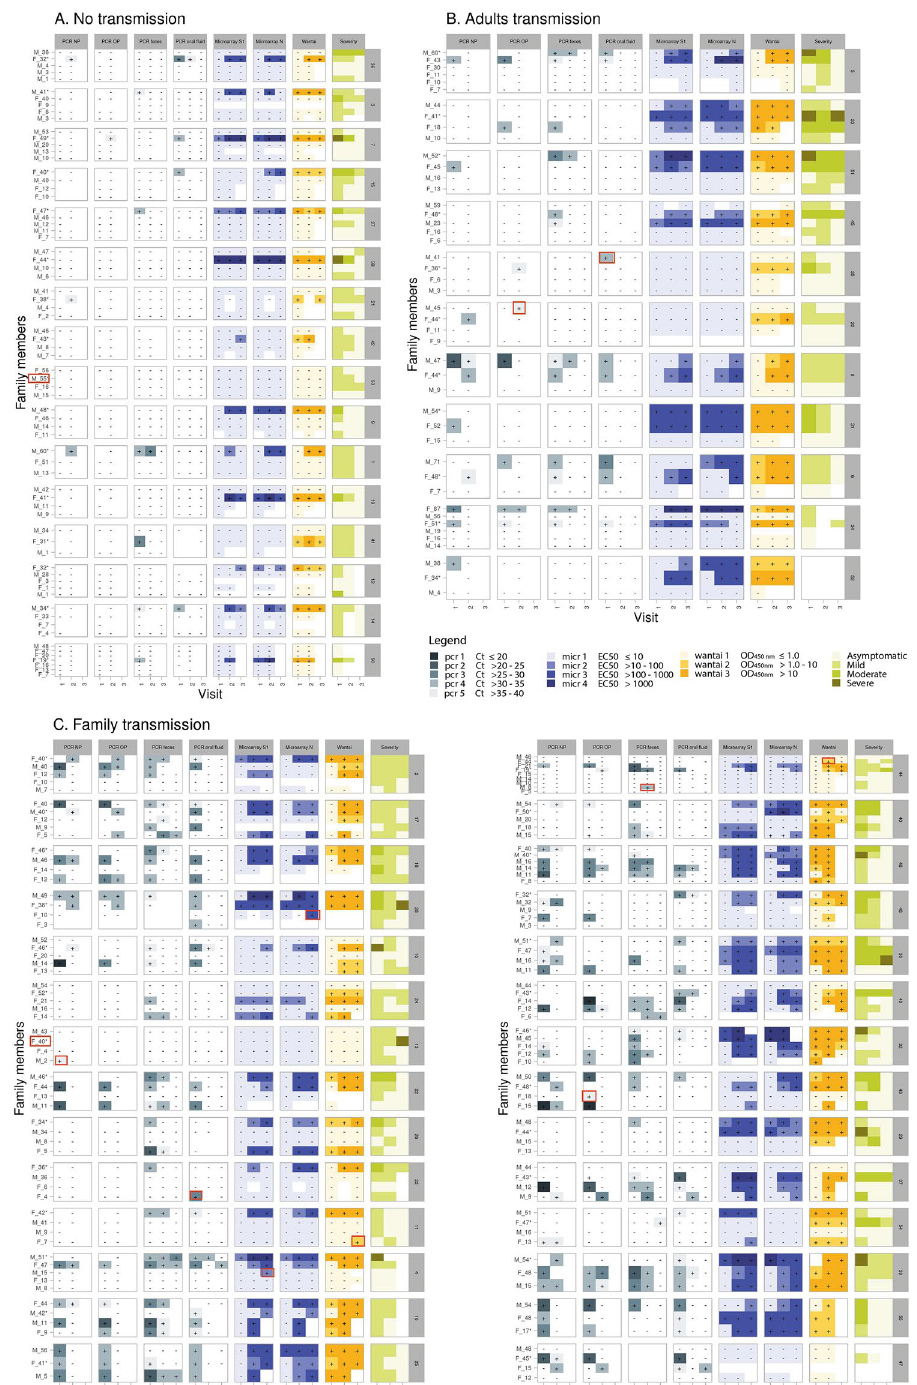
Figure 1. Various transmission patterns of SARS-CoV-2 infection based on different assays and specimen types collected at visits 1, 2 and 3 in households visualized in heatmaps. ( A ) households with no transmission. ( B ) household with only transmission in adults. ( C ) heatmaps of household with transmission in children and possibly also adults. Symptoms can be unrelated to a SARS-CoV-2 infection. On the left side, Male (M) or female (F) and age of the participant is indicated. * Index case. Blanks = not available/tested. Red rectangle: individual with only one test positive on one timepoint. On the right side the Household ID (number) is